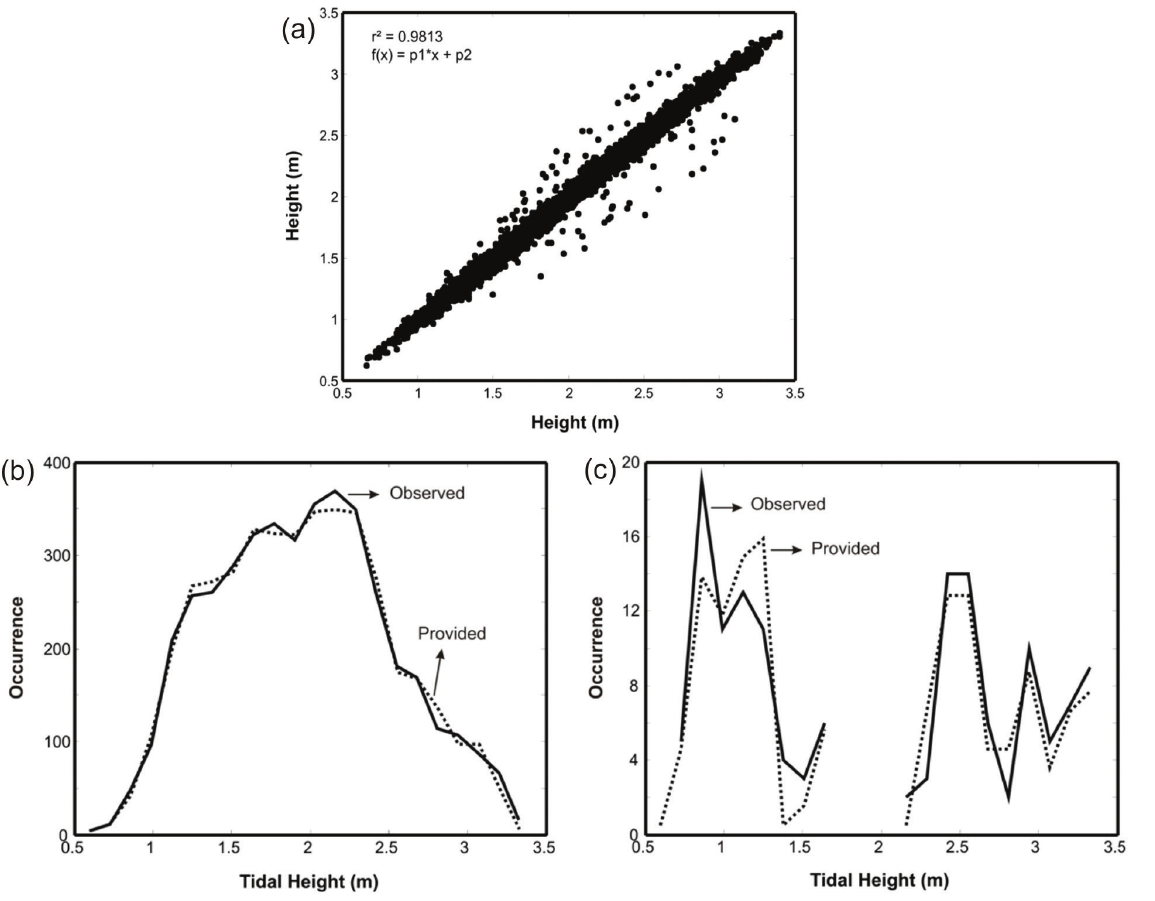
Figure 4 - (a) Relation between the observed and predicted tidal heights. (b) Frequency distribution of observed (full line) and predicted (dashed line) tidal height. (c) Frequency distribution of observed (full line) and predicted (dashed line) of neap and spring tidal